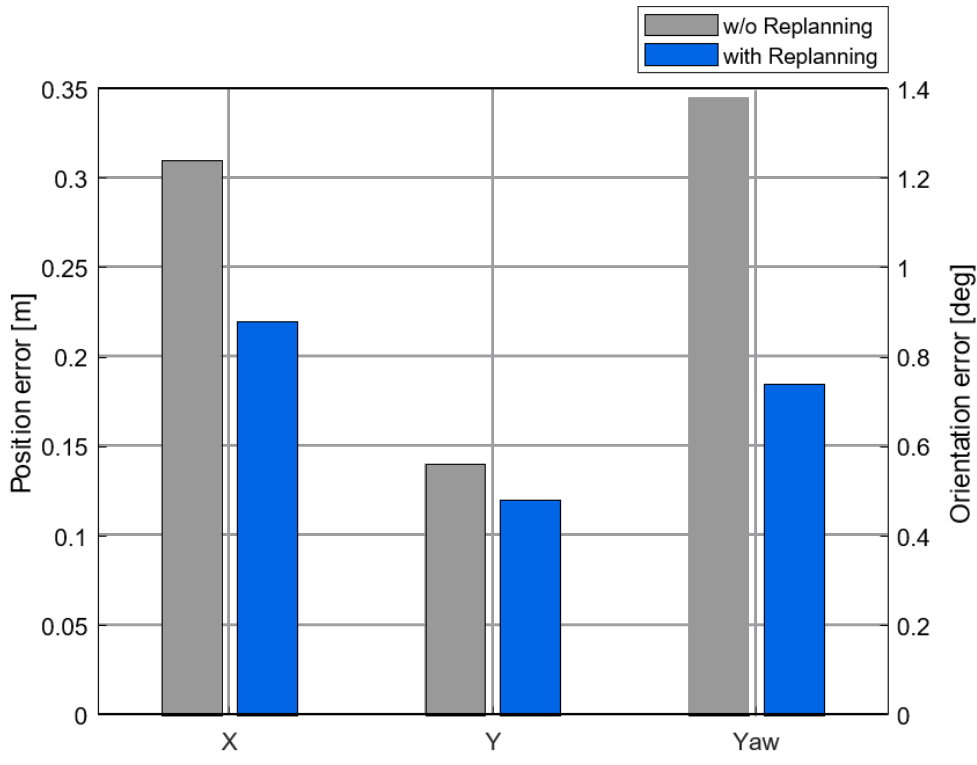
Figure 15. The comparison of average errors between the proposed algorithm and the planner without